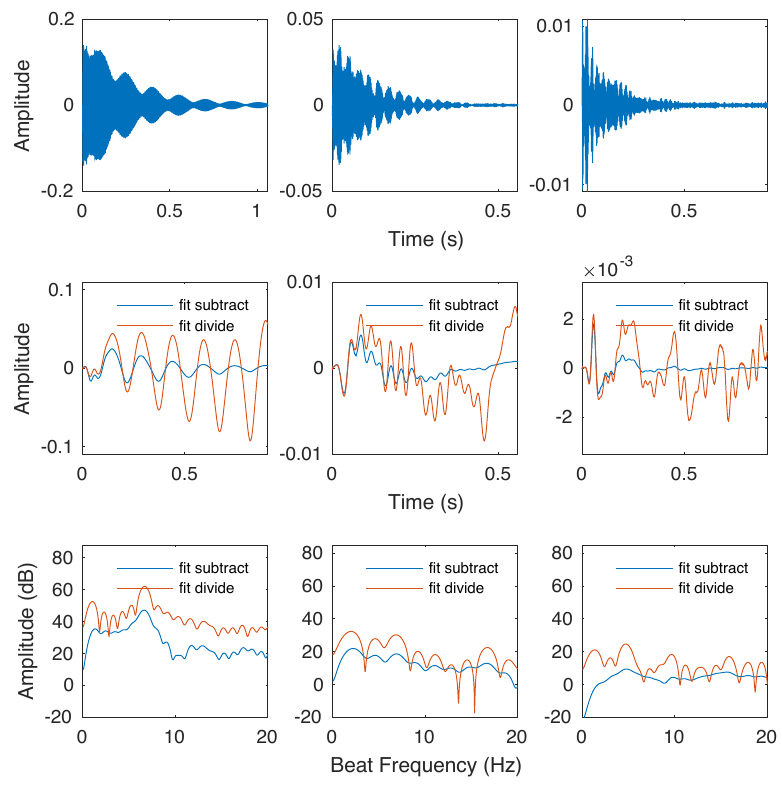
Figure 4. Plots obtained for analysis of beats for the tones Bb6 (being tuned) and Bb5 showing for each matching partial (top row) the bandpassed signal in time domain, (middle) the processed envelope function by subtracting the exponential decay function and by dividing by the exponential function, and (bottom row) the magnitude spectrum of the envelope (processed both ways), from which the frequency of beating can be found by finding the